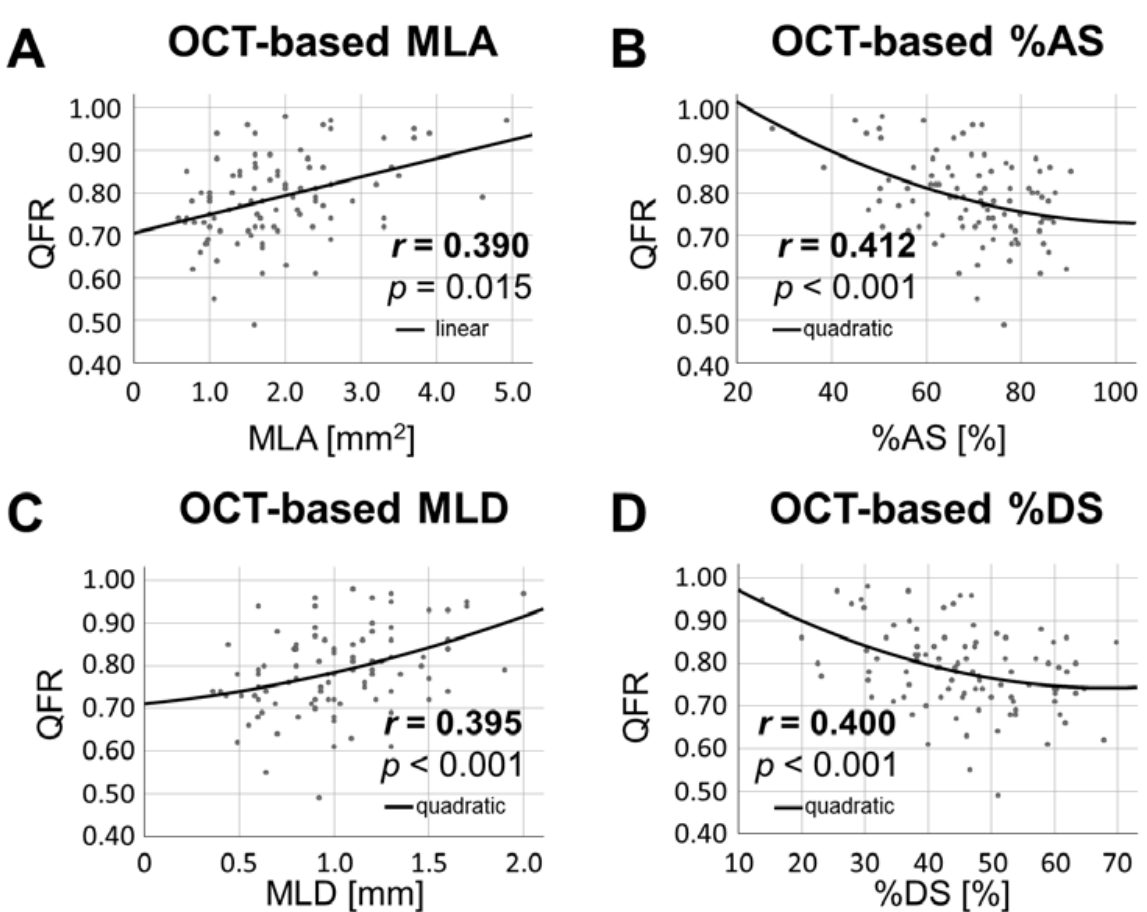
Figure 5. Association between OCT-derived stenosis parameters and QFR. Physiological assessment of coronary lesions through QFR was consistently associated with OCT-derived stenosis parameters as MLA ( A ), percent area stenosis ( B ), MLD ( C ) and percent diameter stenosis ( D ). Abbreviations: MLA: minimal lumen area, %AS = percent area stenosis, MLD: minimal lumen diameter, %DS = percent diameter stenosis.